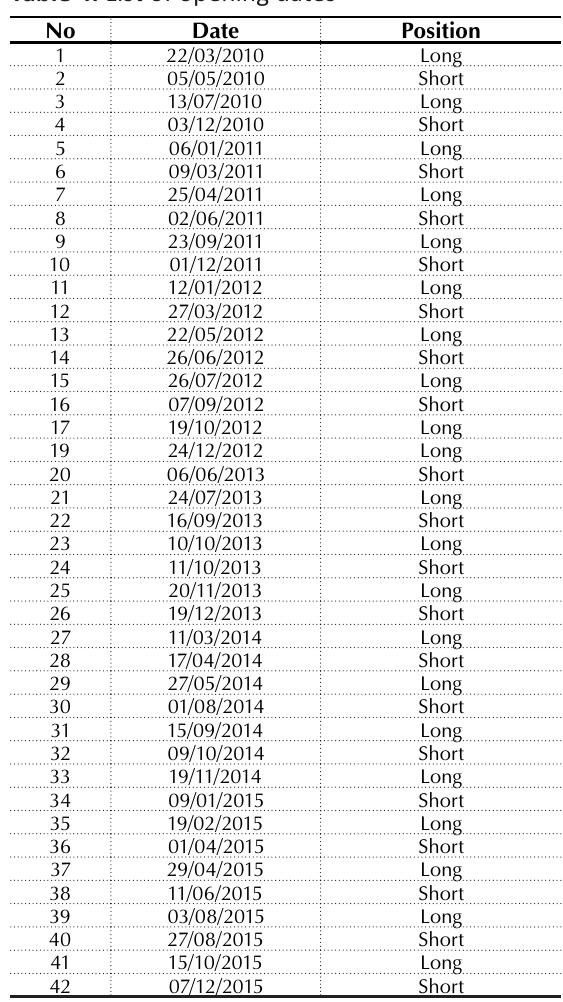
Figure 1. Timing indicator and Bollinger Table 4. List of opening dates